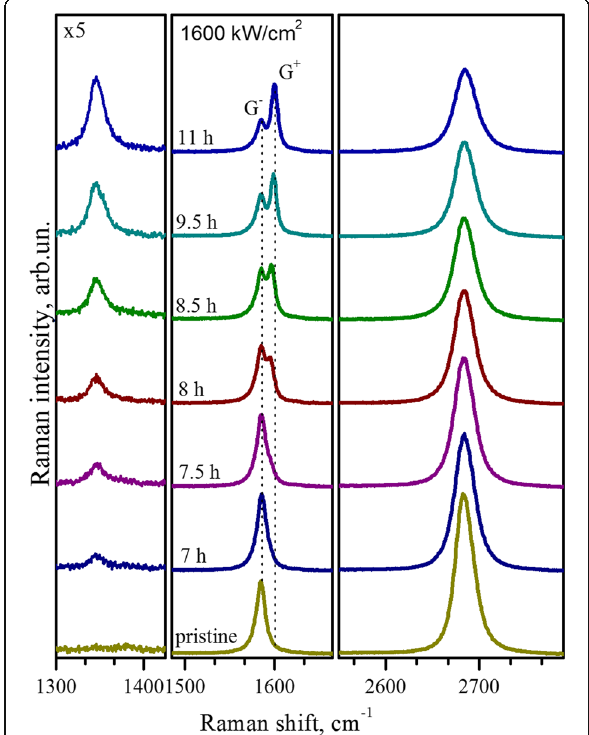
Fig. 6 Raman spectra. Raman spectra of the single-layer graphene before and after exposure by 488-nm laser line with power of 2400 kW/cm 2 . Spectra are normalized to the intensity of the G